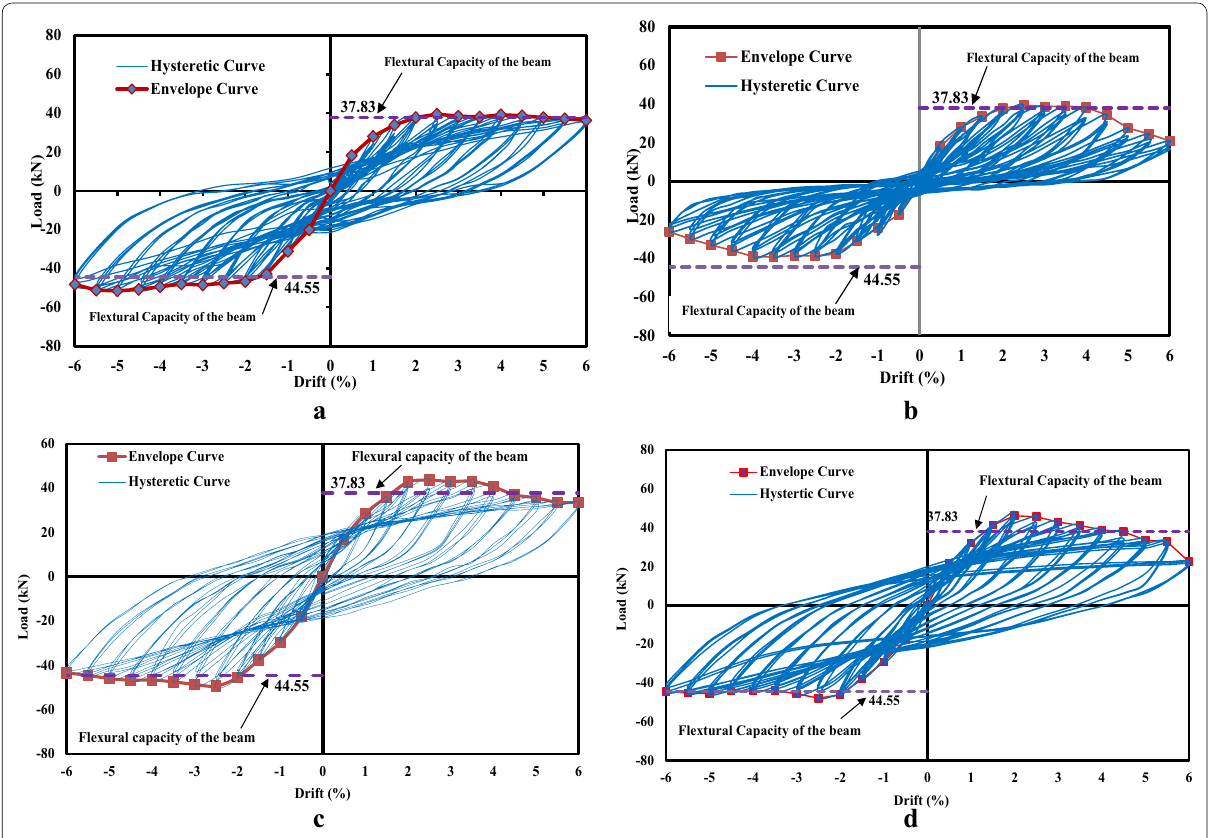
Fig. 18 Hysteresis load-drift response of specimens: a C1 Specimen; b C2 Specimen; c HPFRCC Specimen SC2-A; d HPFRCC Specimen SC2-B.